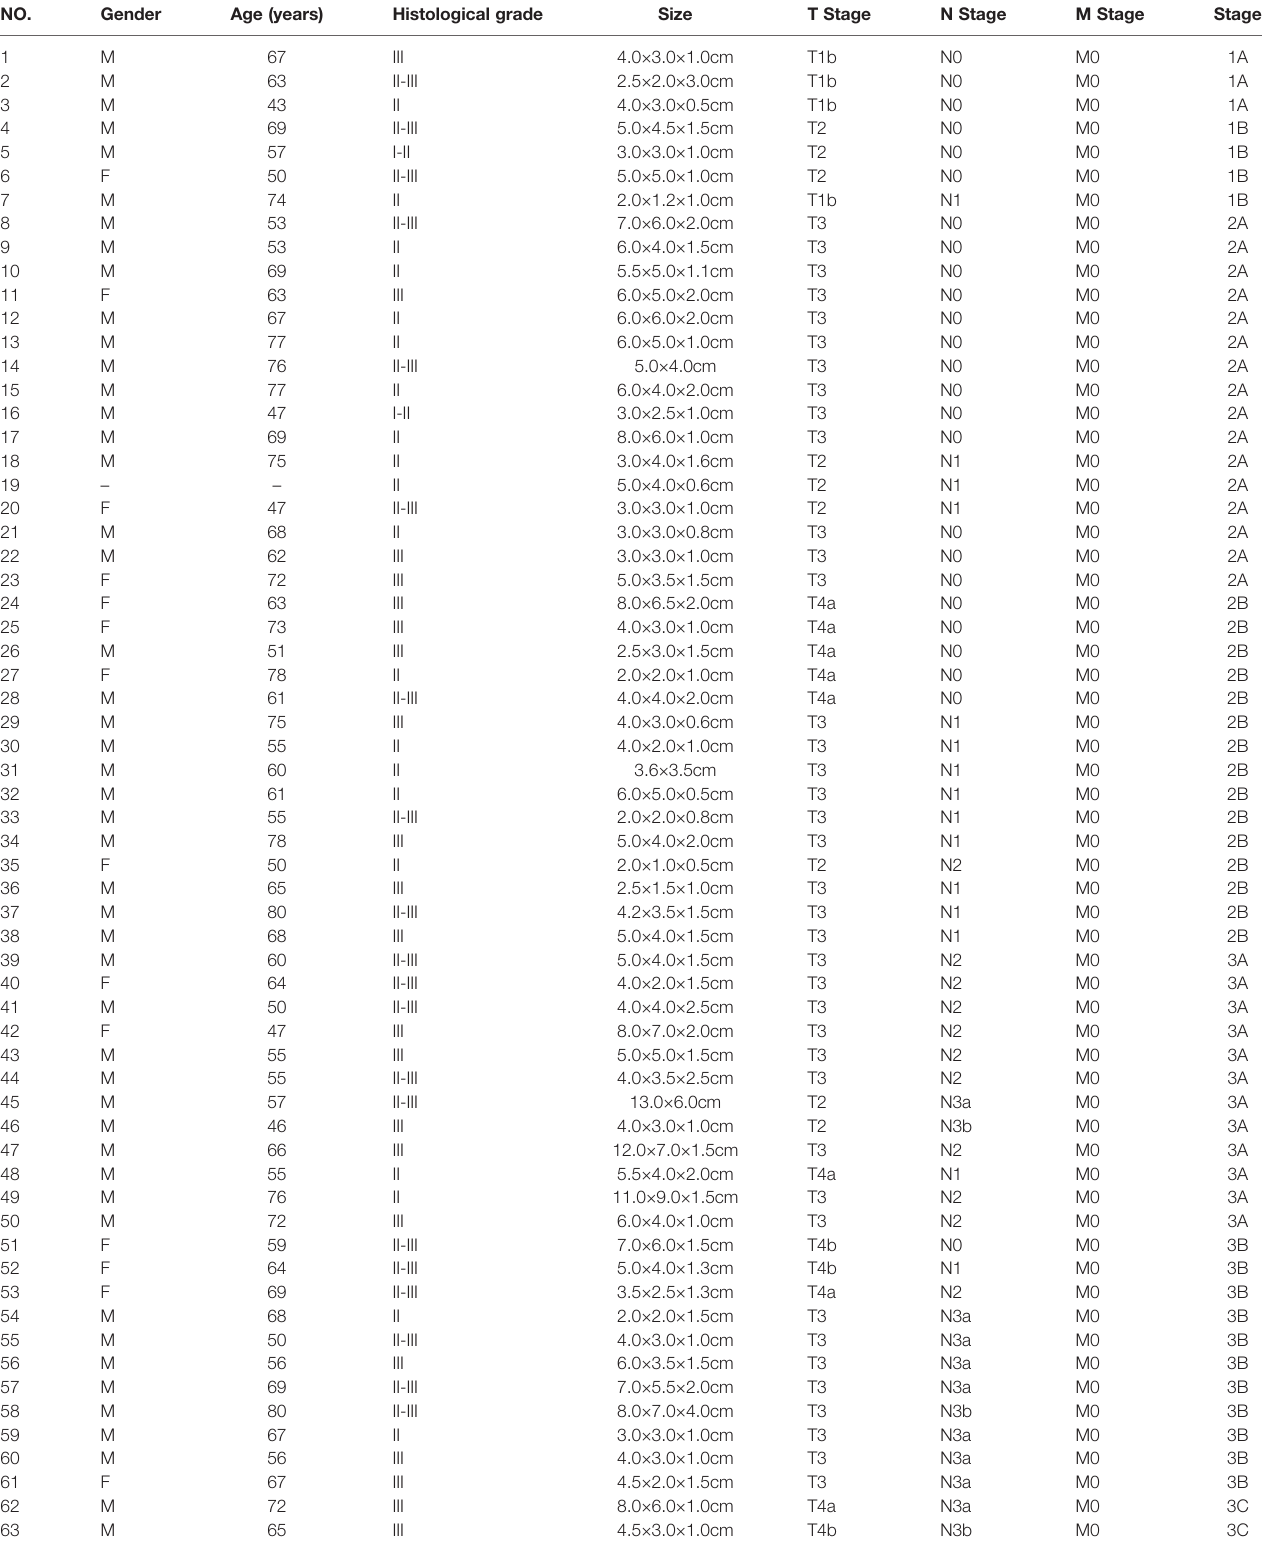
TABLE 1 | Clinical data related to 75 gastric cancer specimens on the tissue microarray chip.